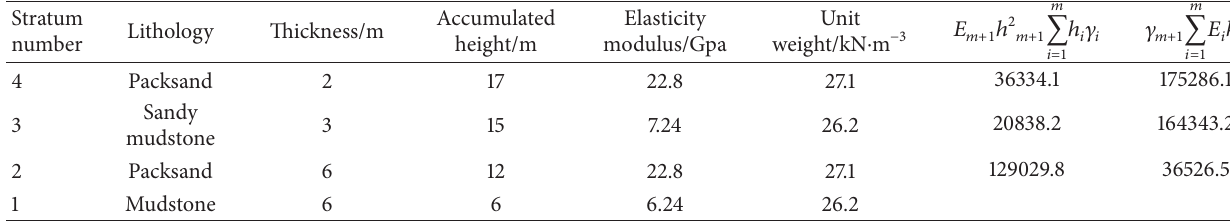
Table 1: Rock mechanics parameters of 15104 face.